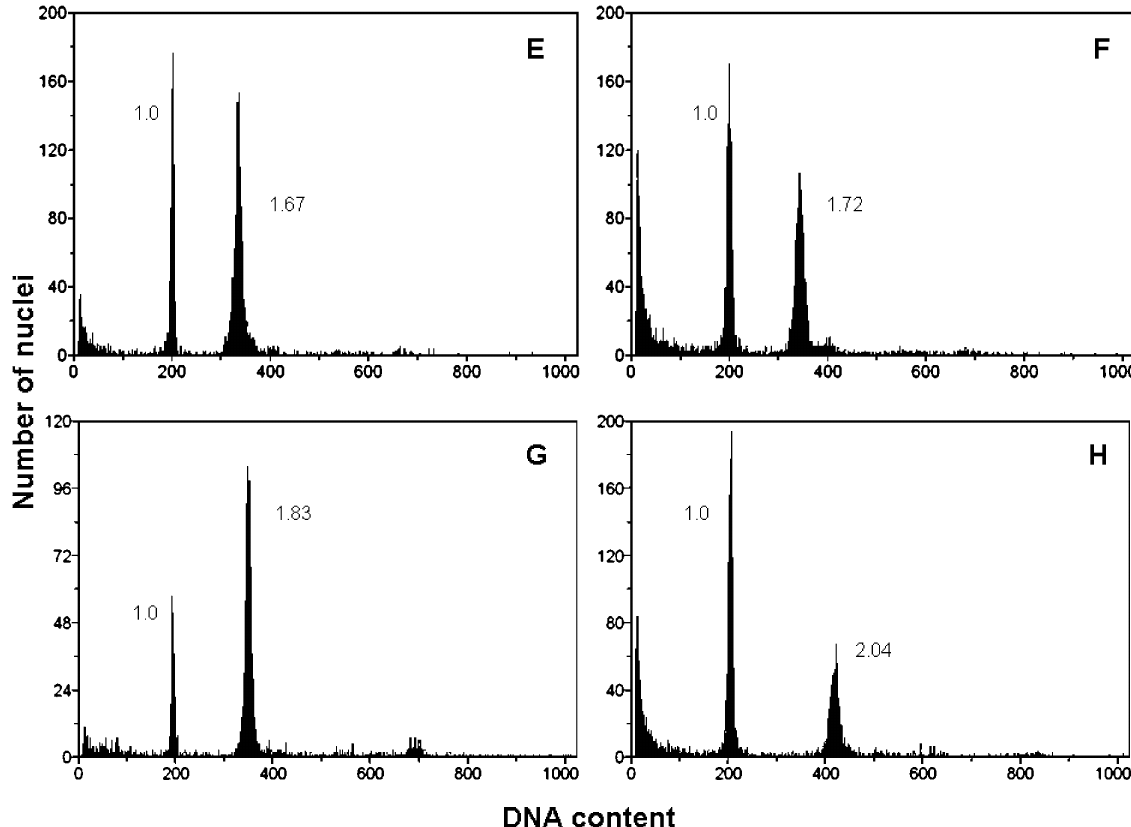
Fig. 1c. (E, F, G and H) Examples of oral lesions with DNA high aneuploid sublines ((E) tongue OPML; (F, G, H) cheek OPMLs). Mean CVs for the G0–G1 diploid and aneuploid peaks were, respectively, 1.56% and 1.90% (CVs evaluated according to the width at 1 / 2 height peak formula; see Section